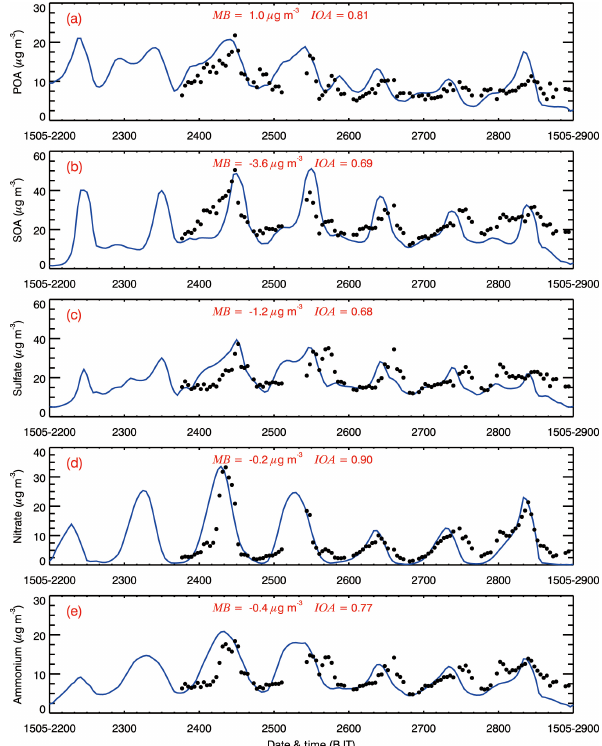
Figure 6. Comparison of measured (black dots) and simulated (black line) diurnal profiles of submicron aerosol species of (a) POA, (b) SOA, (c) sulfate, (d) nitrate, and (e) ammonium at the NCNST site in Beijing from 22 to 28 May